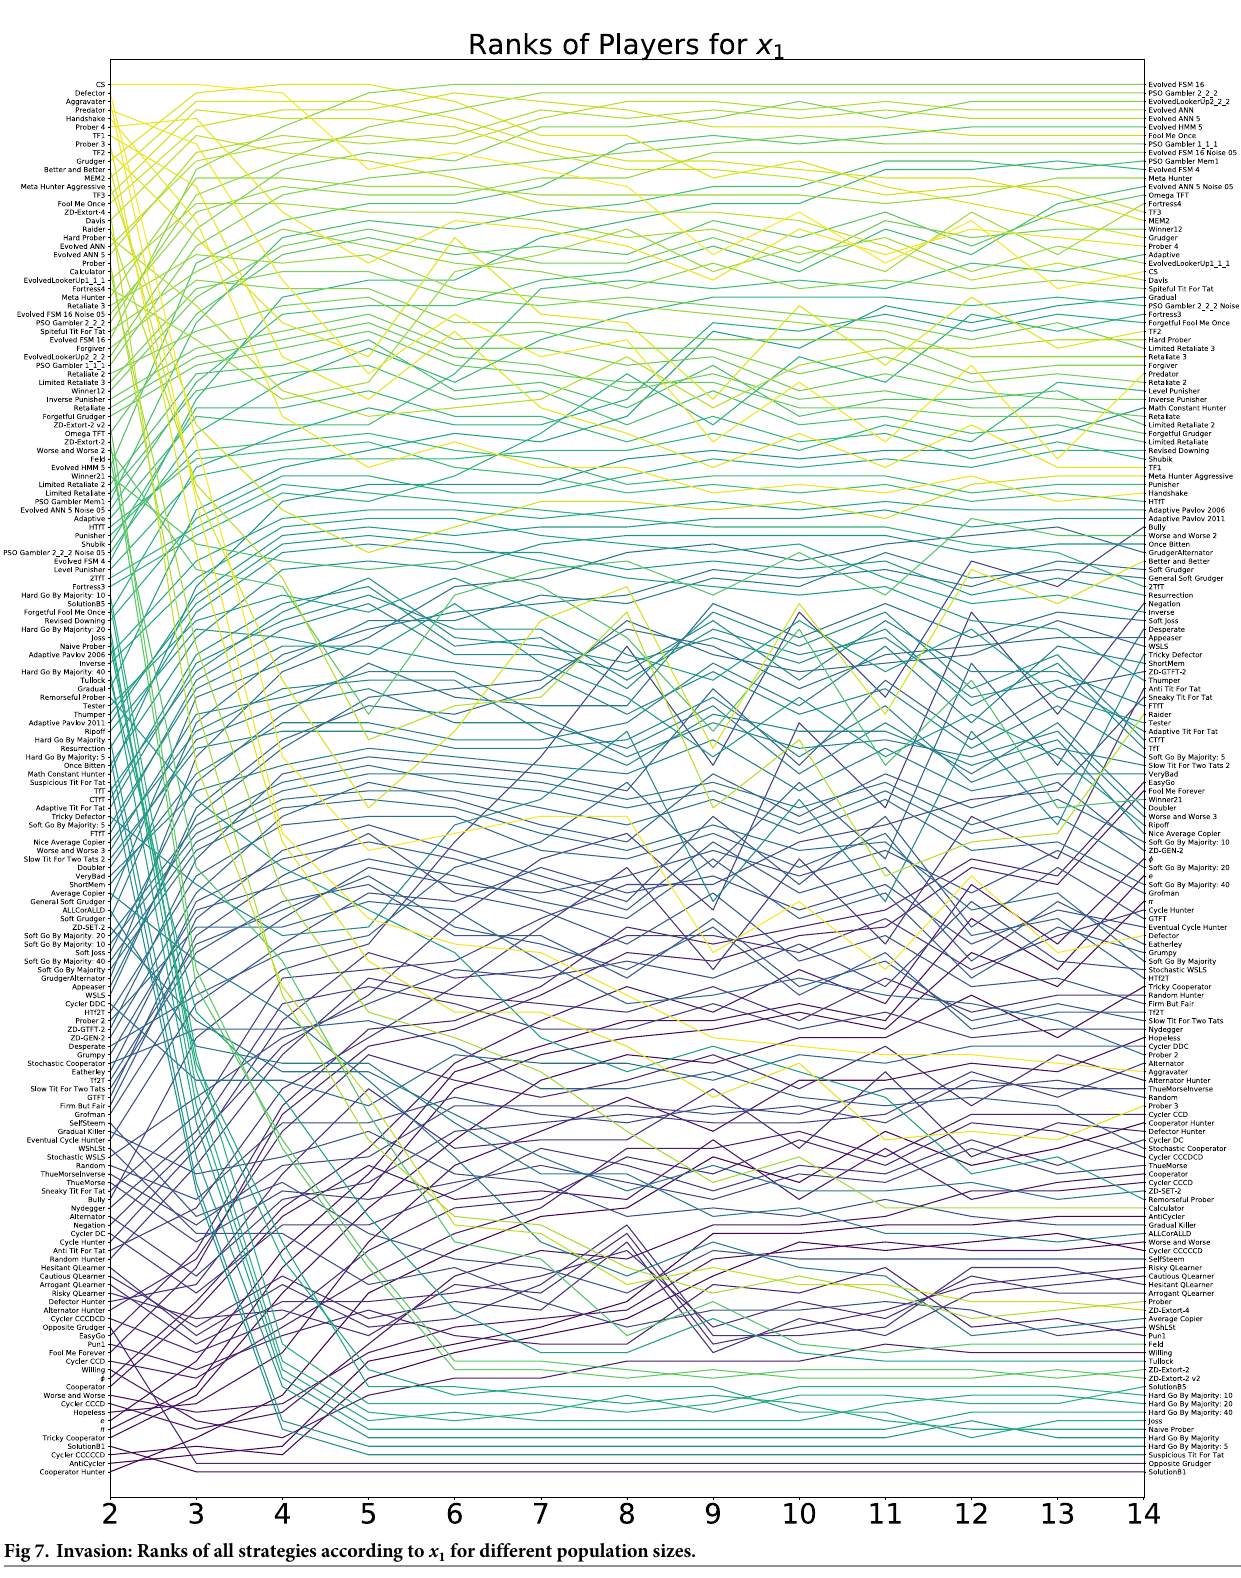
Fig 7. Invasion: Ranks of all strategies according to x 1 for different population sizes.